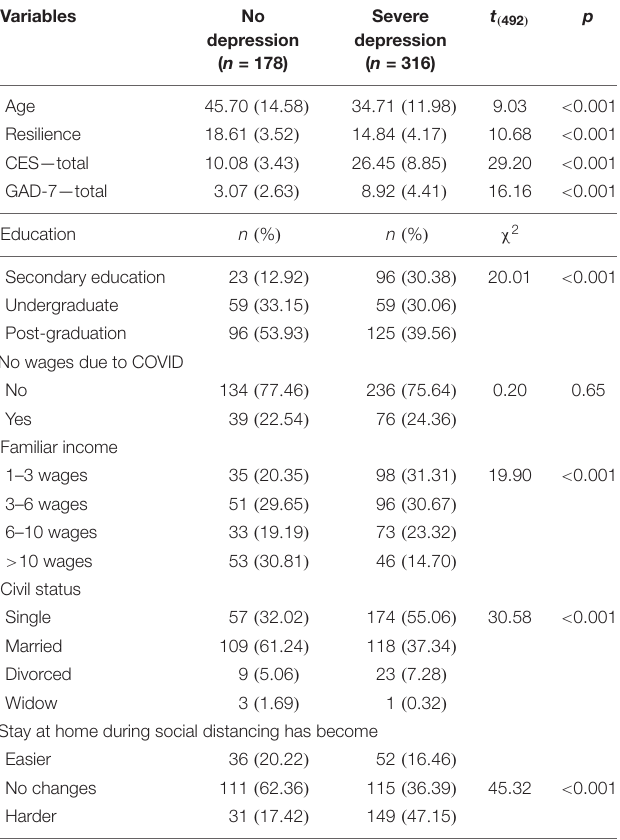
TABLE 1 | The demographic characteristics of our